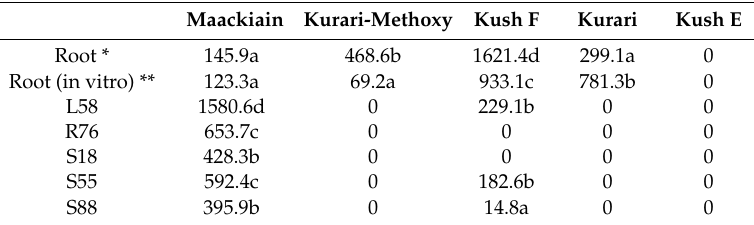
Table 2. Quantitative analysis of maackiain and other isoflavonoids from UHPLC in S. flavescens callus and explant (n = 3 biological